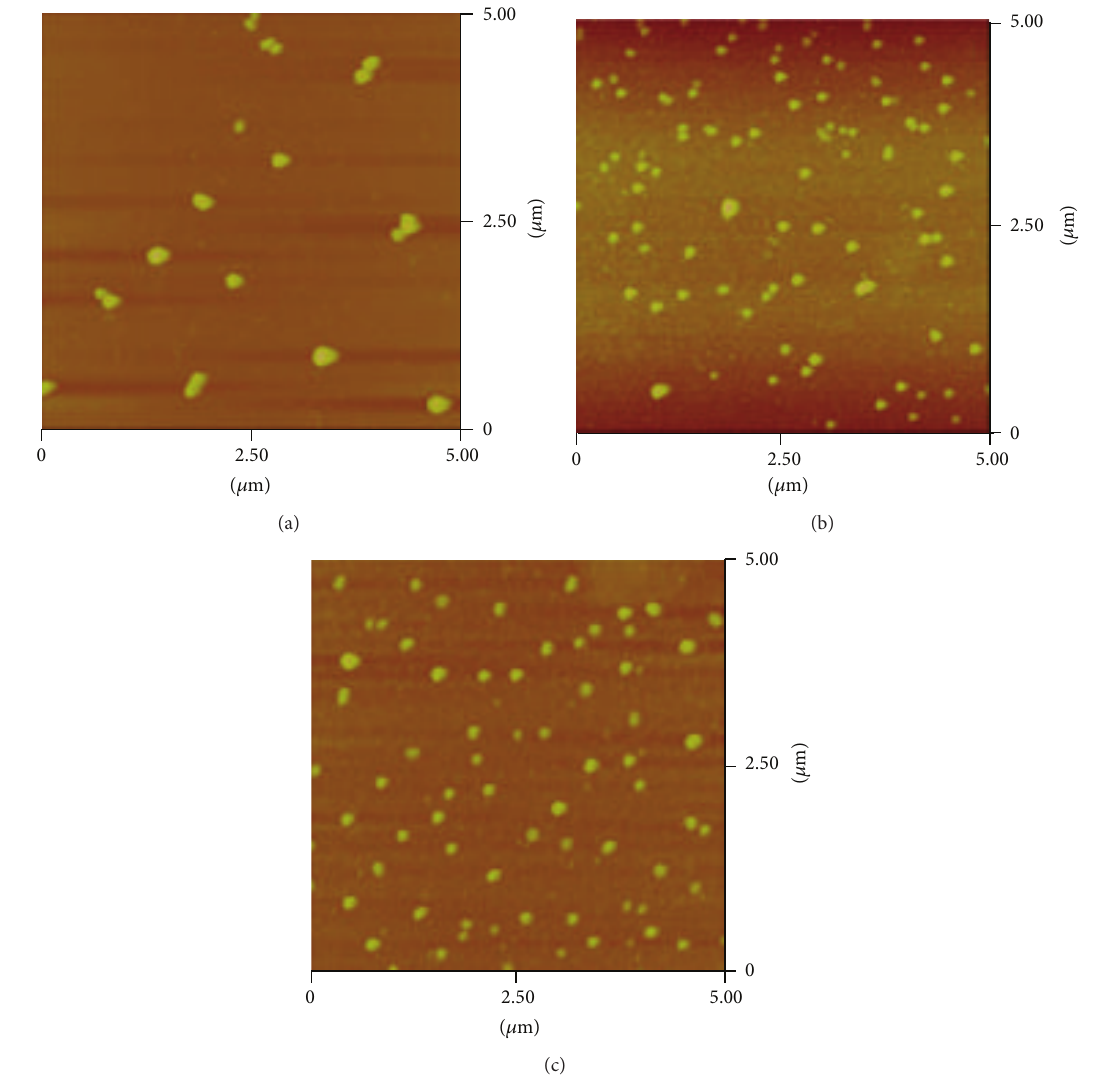
Figure 7: AFM images of DPG at various salinities.